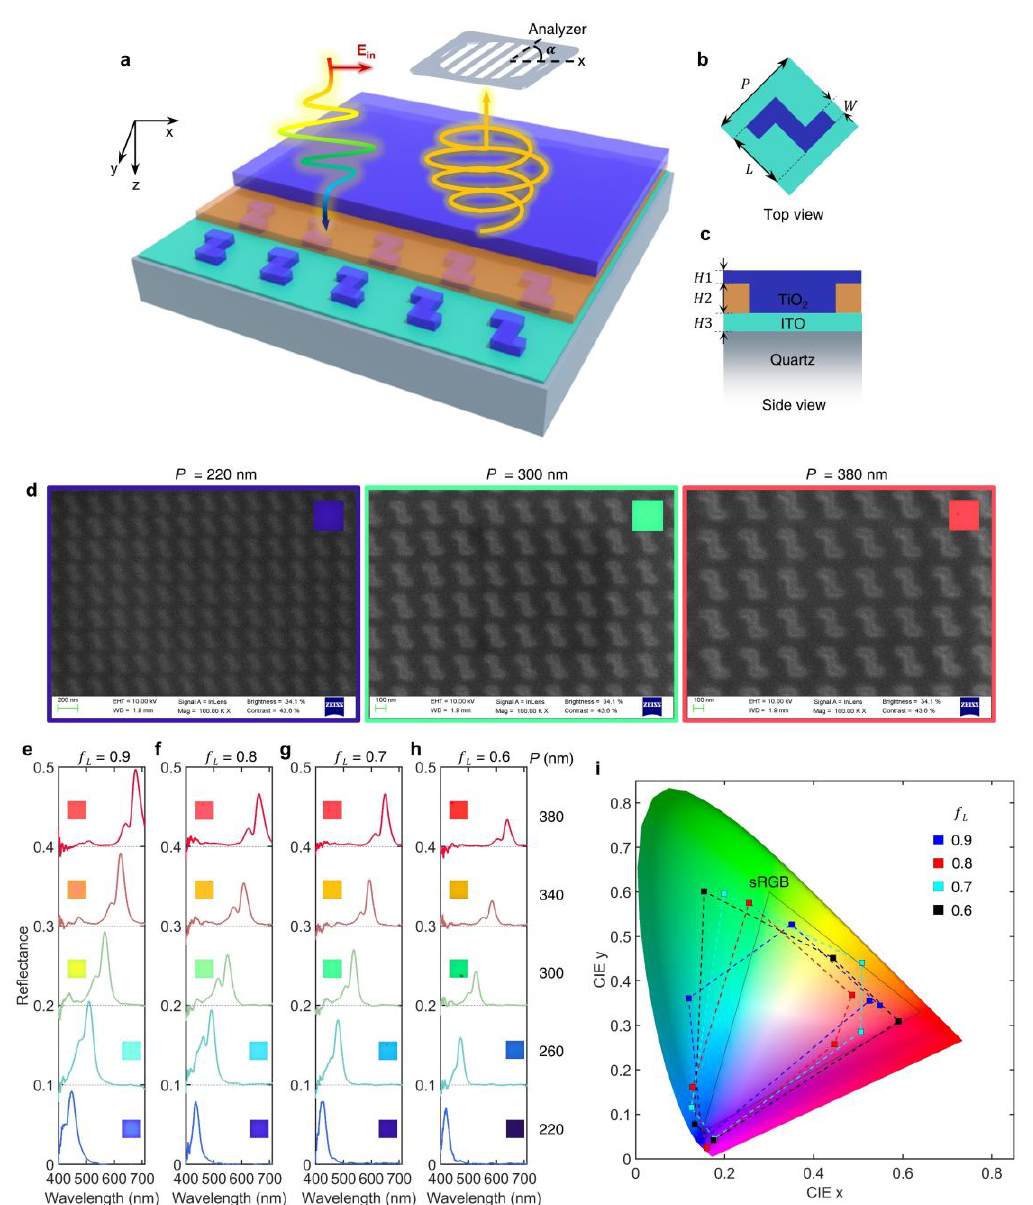
Figure 1. Full-color gamut of color-rendering performance of the embedded chiral metasurfaces. ( a ) Perspective view of the embedded chiral metasurface. ( b ) Top view and ( c ) side view of a single unit cell of the embedded chiral metasurface. ( d ) The top view SEM images of the embedded chiral metasurfaces with P of 220 nm, 300 nm, and 380 nm. The cross‑polarization reflectance spectra and corresponding micrographs with f L of ( e ) 0.9, ( f ) 0.8, ( g ) 0.7, and ( h ) 0.6 at different p from 220 nm to 380 nm. ( i ) The corresponding CIE 1931 chromaticity diagram of ( e – h